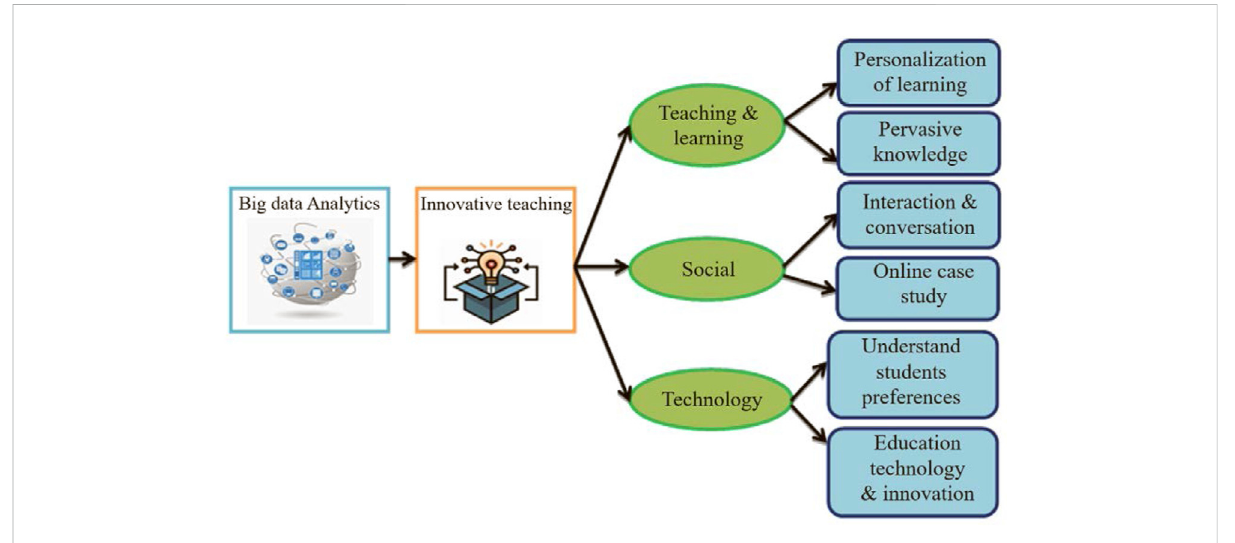
FIGURE 1 Big data analytics and innovative teaching process in rural